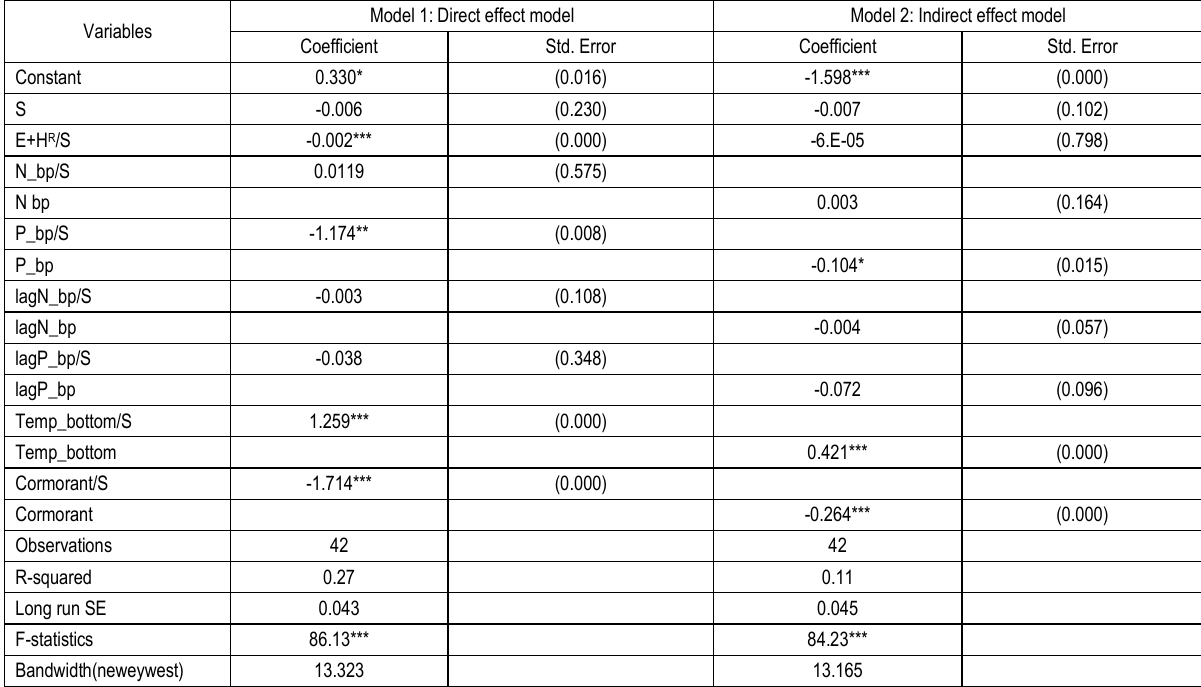
Table 2. Fully modified ordinary least square (FMOLS) estimates of growth function for perch populations off the east coast of Sweden. For abbreviations, see Table 1